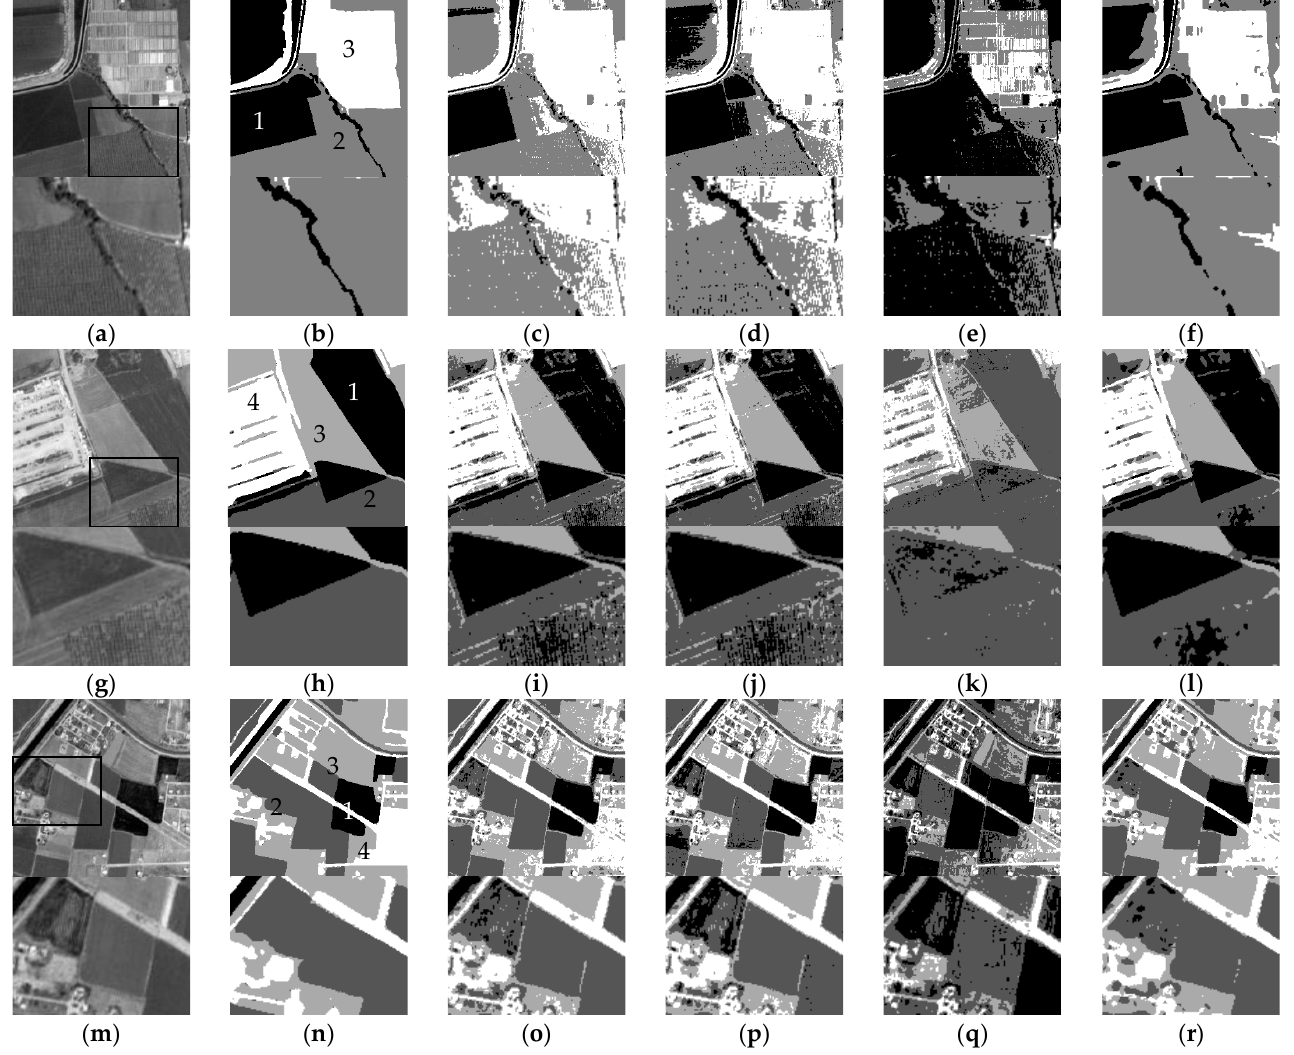
Figure 7. High-resolution panchromatic images and their segmentation results. ( a , g , m ) high-resolution panchromatic images with noise, and the region in the black square is highlighted, ( b , h , n ) standard segmentation images, and 1 – 4 are the labels of regions, ( c , i , o ) FCM algorithm, ( d , j , p ) GMM algorithm, ( e , k , q ) SMM algorithm, ( f , l , r ) HSMM algorithm.